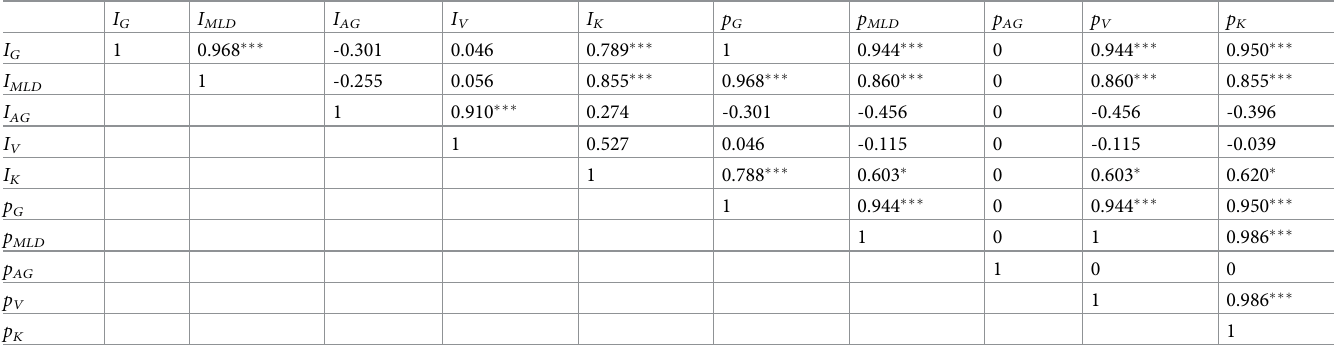
Table 3. Correlations between inequality measures and benchmark